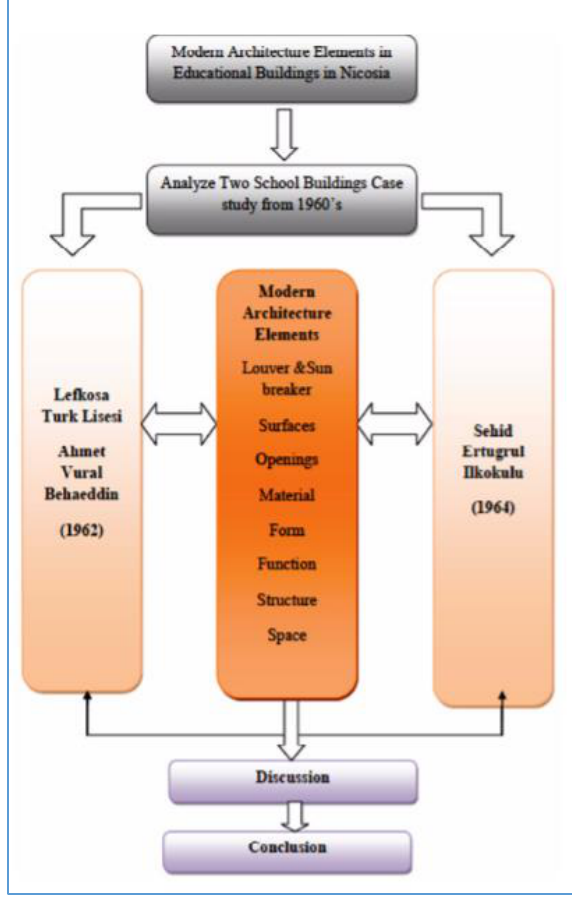
Figure 5. Methodology